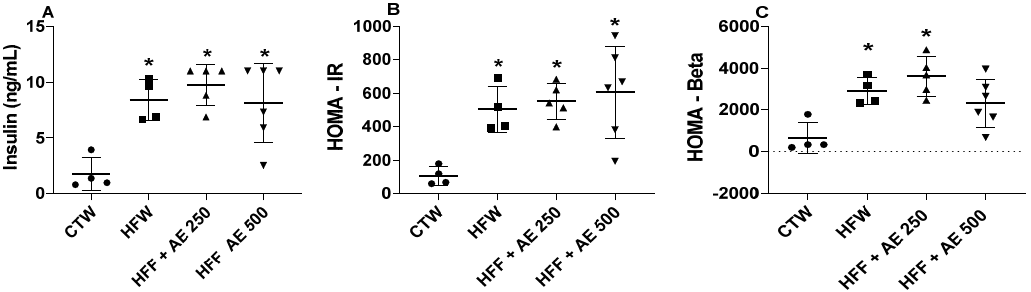
Figure 5. Evaluation of the insulin levels, homeostatic model assessment for insulin resistance (HOMA-IR), and homeostatic model assessment for β cells (HOMA- β ). ( A ) The insulin serum levels (ng / mL). ( B ) HOMA-IR; ( C ) HOMA- β of animals evaluated at the end of the treatment (16th week) of full black circle: CTW (CT + drinking water, n = 4), full black quadrilateral: HFFW (high-fat / high-fructose diet + drinking water, n = 4); black up-pointing triangle: HFF + AE 250 (HFF + M. citrifolia fruit aqueous extract of 250 mg / kg of body weight, n = 5); and black down-pointing triangle: HFF + AE 500 (HFF + M. citrifolia fruit aqueous extract of 500 mg / kg, n = 6) groups. The results are expressed as the mean ± SEM. * = p ≤ 0.05 vs. CTW. ANOVA, followed by the Tukey post-test.